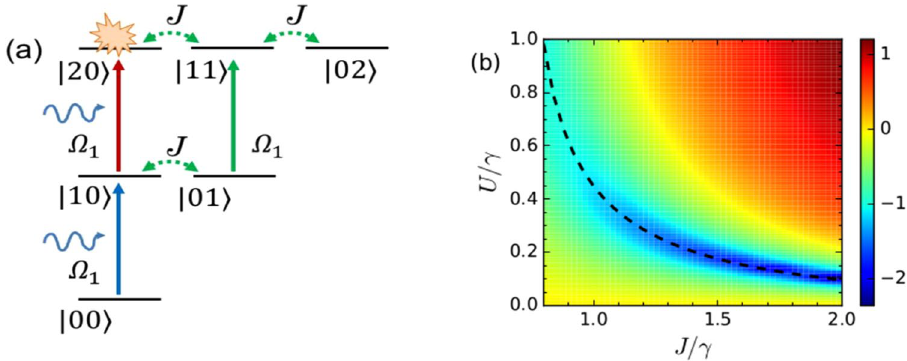
Figure 2. ( a ) Different two-phonon excitation paths that can lead to interference-based phonon blockade for a single pump applied on the primary resonator 30 , and ( b ) logarithmic plot of g (0) and J with optimum values of Δ . The black dashed line represents the optimum values of U / γ corresponding to the values of J / γ